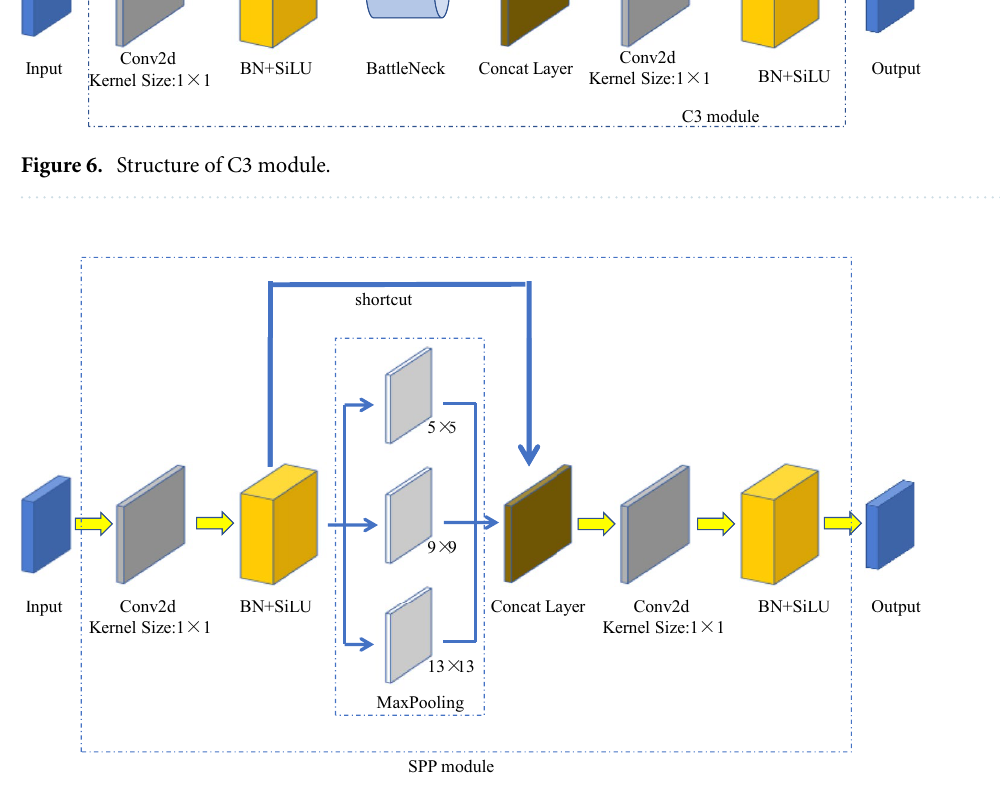
Figure 7. Structure of SPP